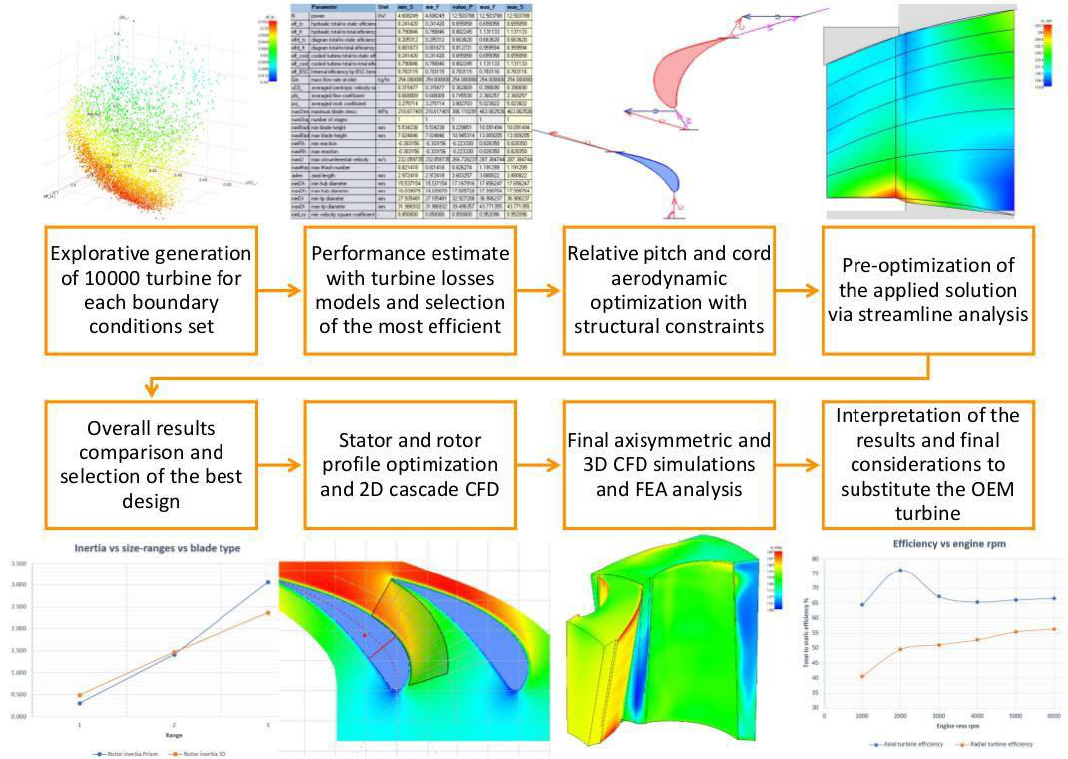
Figure 5. Schematic of the turbine design methodology.